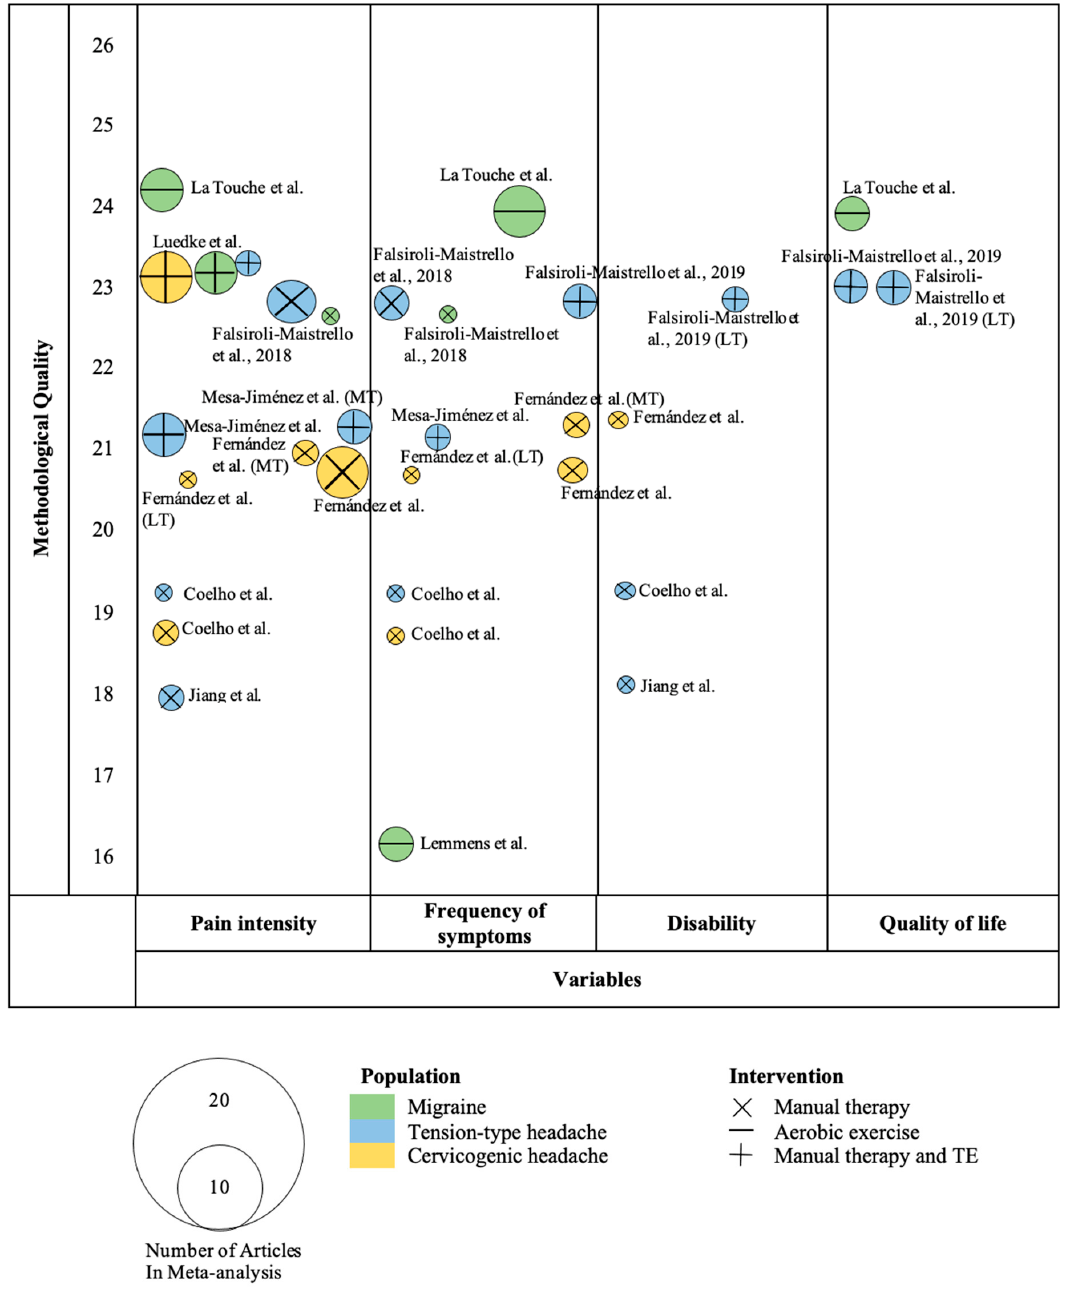
Figure 3. Descriptive evidence map of meta-analyses. TE, therapeutic exercise; MT, mid-term; LT, long-term. On the x -axis the studies are classified according to the study variable, while on the y -axis they are categorized according to their score on the Modified Quality Assessment Scale for Systematic Reviews (AMSTAR), with a score above 20 being considered high-quality.